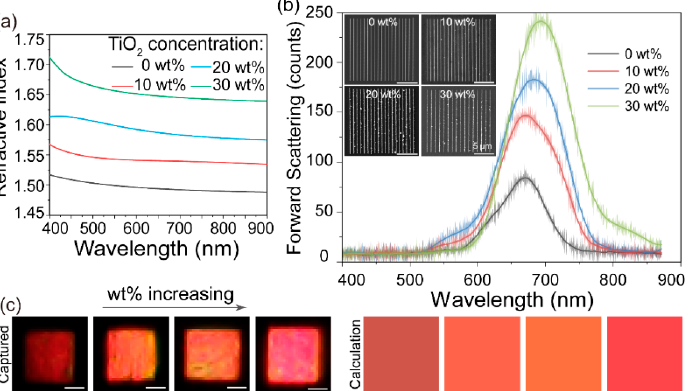
Figure 3. ( a ) The measured effective refractive index with four different concentrations via the ellipsometer. ( b ) The measured forward scattering spectra of four diffractive gratings with different concentrations. Insets: The SEM images of gratings with different TiO 2 concentrations. ( c ) The calculated and measured dark-field color images captured by CCD camera. All the scale bars are 5 μ m.